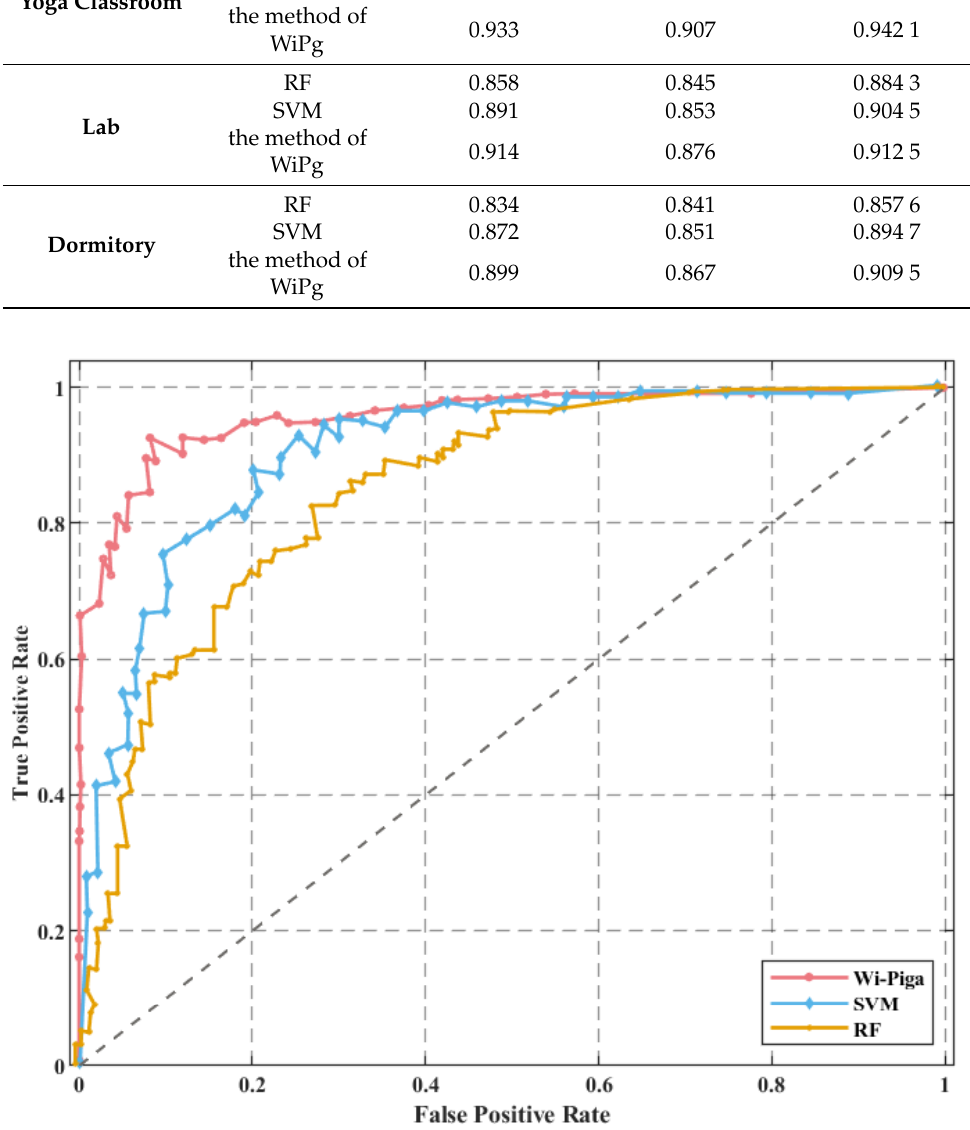
Figure 17. ROC curve comparison in the yoga classroom.